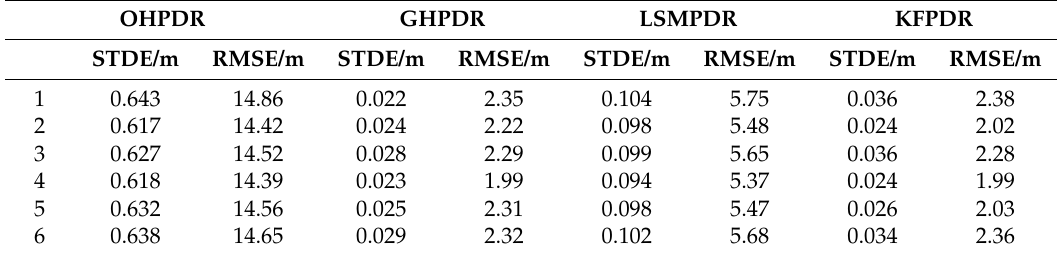
Table 4. Positioning analysis for different solutions associated with PDR in B–C area on the 5th floor.